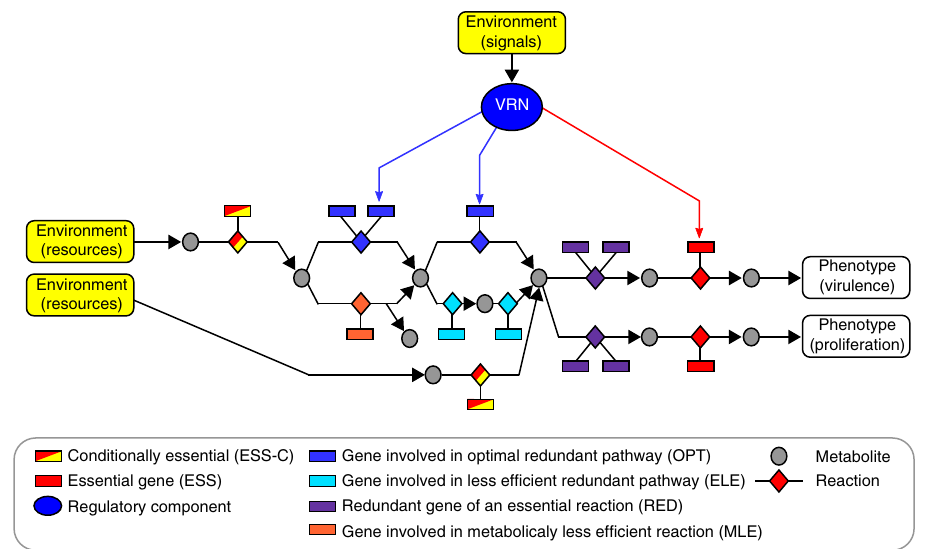
Fig. 7 Functional connections of the VRN with the metabolic network and their impact on the control of phenotypic robustness. Rectangles, diamonds, and circles symbolize genes, enzymatic reactions, and metabolite products, respectively. The action of the VRN is either on the control of robust nodes of the primary metabolic network (blue arrows) or on essential required for expression of virulence phenotypes (red arrow). Examples of the fi rst class (genes colored in blue) are the tryptophan biosynthetic pathway (genetic redundancy) and the methionine biosynthetic pathway (pathway redundancy), see details in